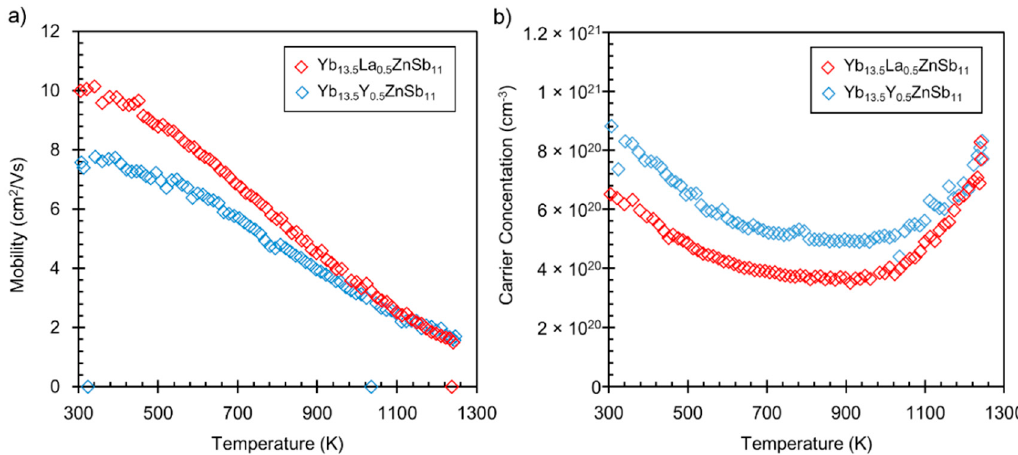
Figure 5 . ( a ) Mobility and ( b ) carrier concentration of the Yb 13.5 RE 0.5 ZnSb 11 (rare earth (RE) = Y, La)